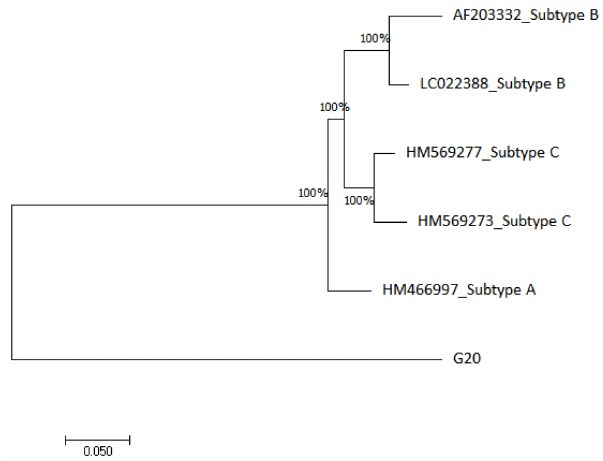
Figure 3. The evolutionary relationship of the HIV-1 sample (G20) with HIV-1 reference genomes from NCBI database was inferred using the maximum likelihood phylogeny method.